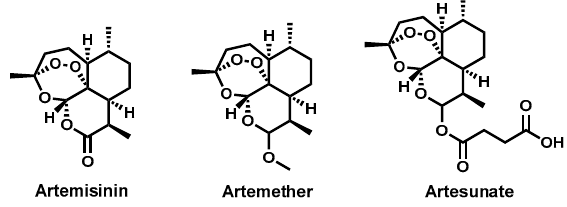
Figure 17. Artemisinin derivatives with antischistosomal potency.